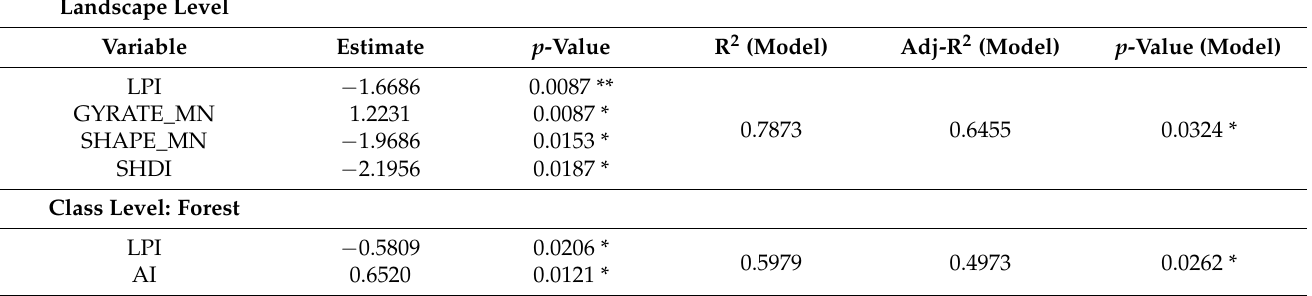
Table 1. The significance of the landscape metrics involved in the multiple regression and the degree of model fit (significance: * p < 0.05, ** p < 0.01).